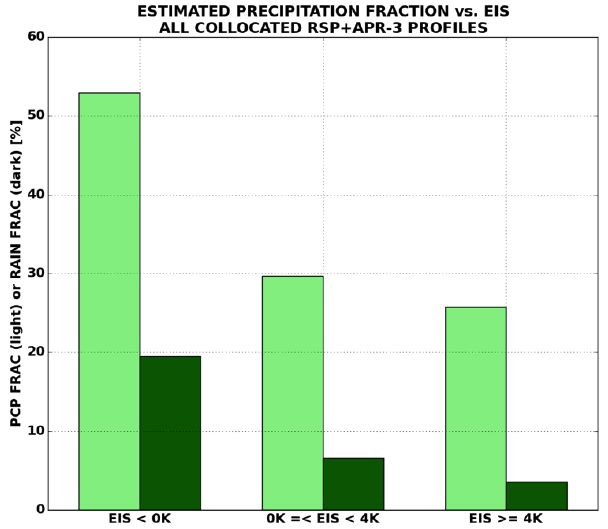
Figure 11. Precipitation fraction (light green) and surface rain frac- tion (dark green) under unstable (EIS < 0K), marginally stable (0K ≤ EIS < 4K), and stable (EIS > 4K) conditions. Precipitation fraction was estimated from all collocated APR-3 and RSP profiles with a maximum reflectivity of − 15dBZ or larger. Surface precip- itation fraction was estimated from any profile where the retrieved surface precipitation rate exceeded 0.01mmd − 1